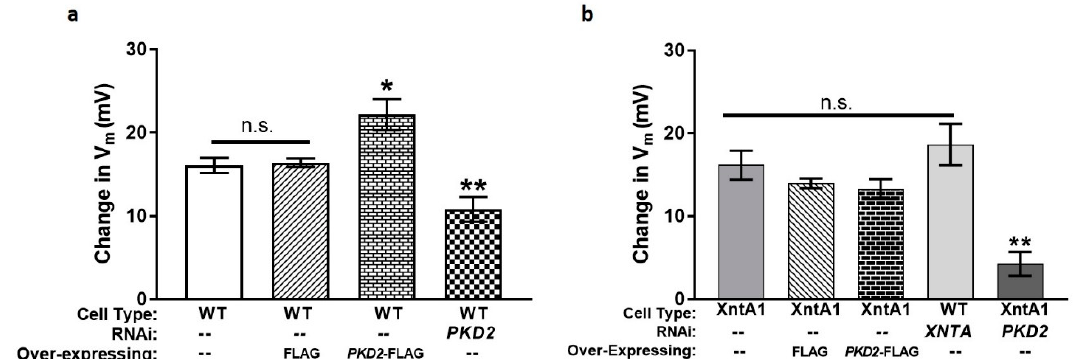
Figure 9. Depletion of PKD2 in deciliated cells decreases the membrane permeability to Mg 2+ . Cells were freshly deciliated and recorded from in 1 mM KCl without, and then with, 0.5 mM MgCl 2 . ( a ) No significant difference was observed between deciliated WT cells and deciliated WT cells over-expressing FLAG (n.s. = not significantly different). Deciliated WT cells over-expressing PKD2 -FLAG show a significant increase in Mg 2+ permeability compared to deciliated WT and deciliated WT over-expressing FLAG (* = P < 0.05). Deciliated WT cells depleted in PKD2 show a significant decrease in membrane permeability to Mg 2+ compared to the others (** = P < 0.01). ( b ) Deciliated XntA1 mutants, deciliated over-expressing XntA1 mutants, and deciliated WT cells depleted in XNTA are not significantly different compared to one another (n.s.). Deciliated XntA1 mutants depleted in PKD2 show almost a complete loss of membrane permeability to Mg 2+ that is significantly different from all